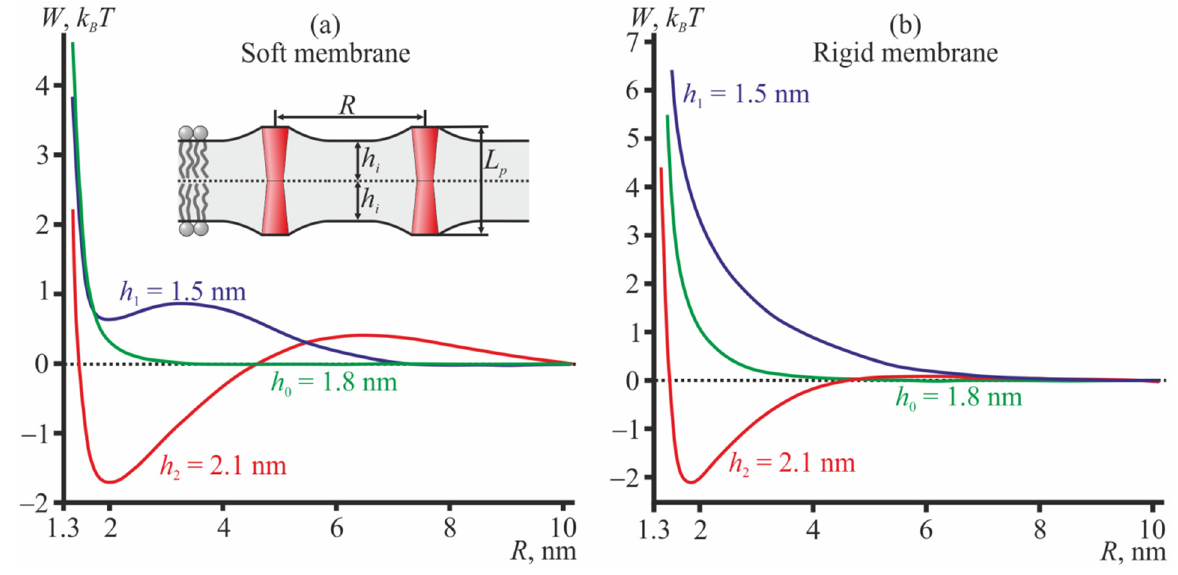
Figure 3. The interaction potentials of two hourglass-like TMDs ( a ) in the disordered (soft) membrane; ( b ) in the ordered (rigid) membrane. The monolayer hydrophobic thicknesses are shown as follows: blue curves— h 1 = 1.5 nm; green curves— h 0 = 1.8 nm; red curves— h 2 = 2.1 nm. The inset in panel ( a ) illustrates two hourglass-like TMDs in the thin bilayer; L p = 2 h 0 = 3.6 nm.